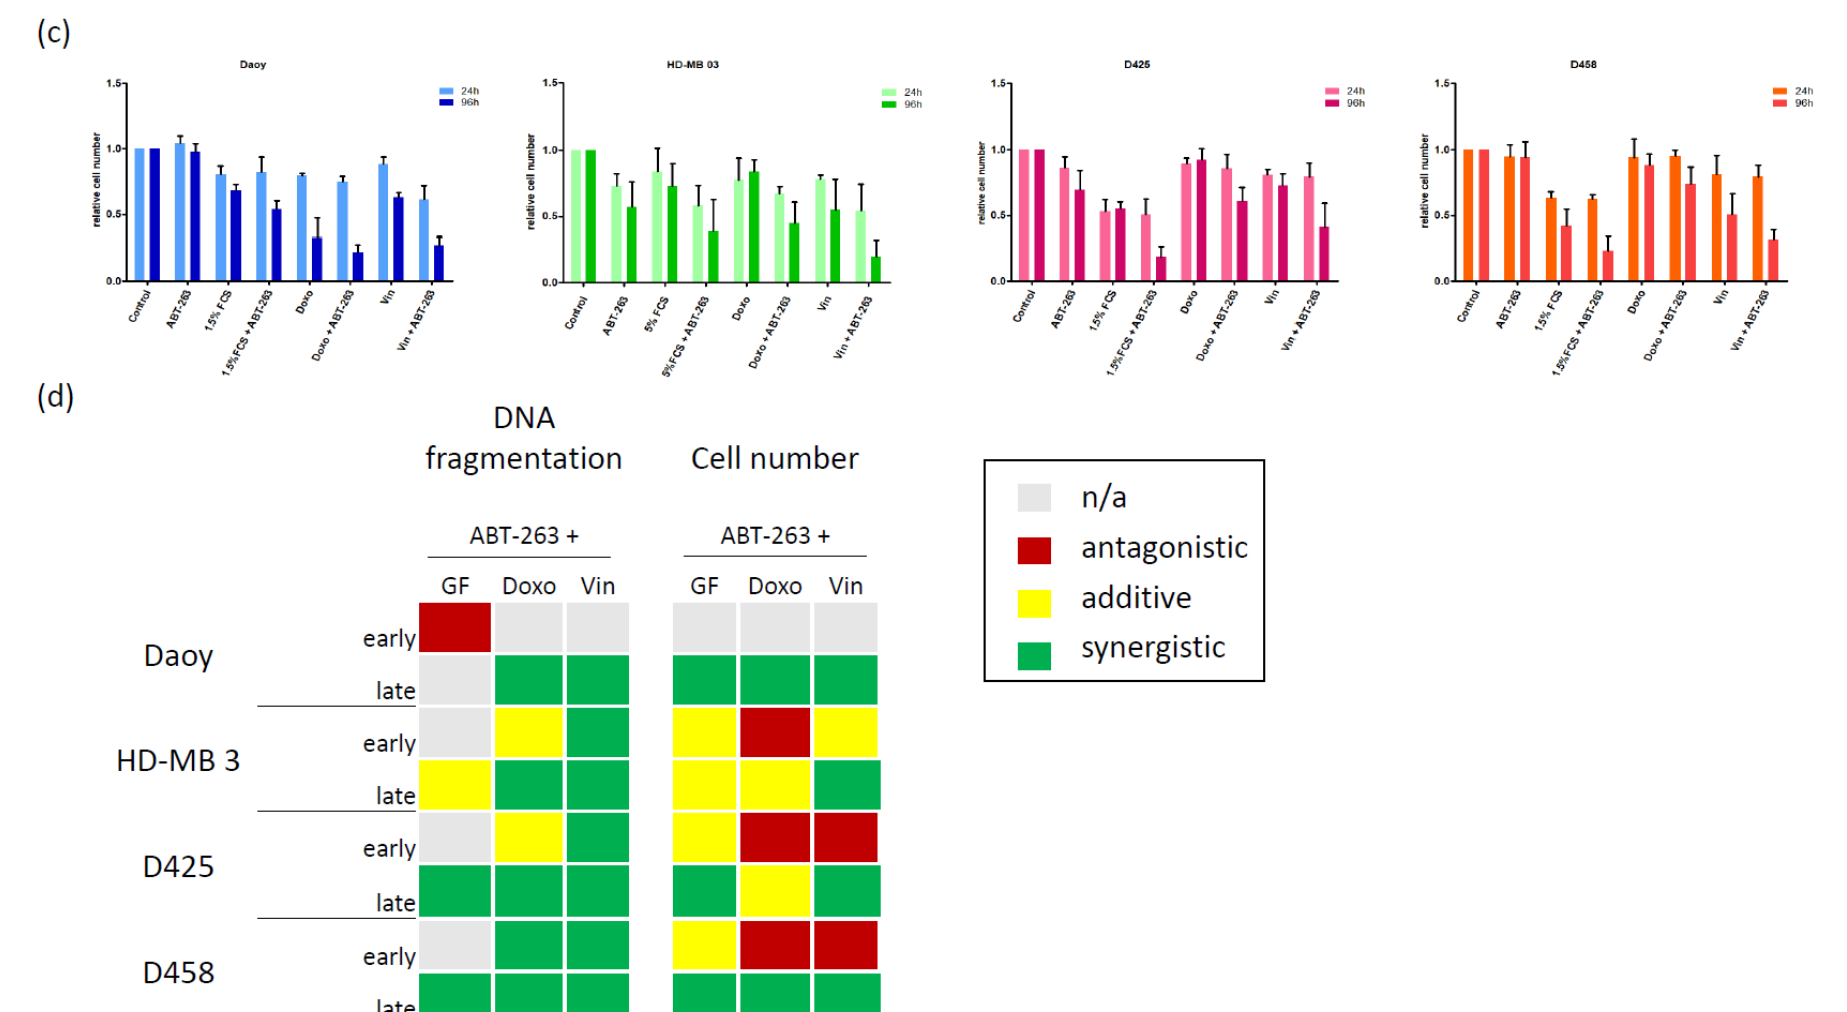
Figure 2. The Bcl-XL/Bcl-2 inhibitor ABT-263 shows therapeutic potential in medulloblastoma (MB) cell lines. ( a ) Monotreatment with ABT-263 affects the metabolic activity of MB cell lines. The MB cell lines were seeded and stimulated with a serial dilution of ABT-263 for 24 and 96 h. The relative viability of the respective